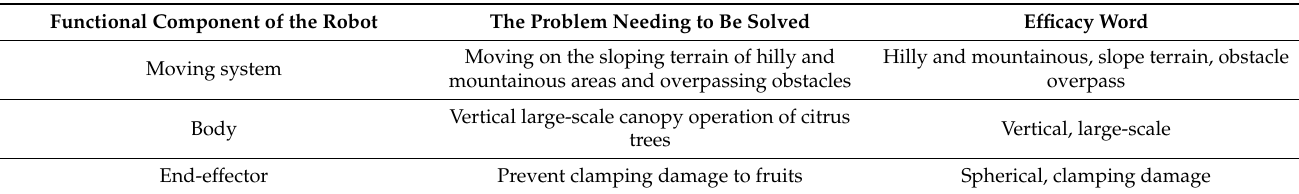
Table 4. Key problems to be solved for each functional component of the citrus picking robot and the corresponding efficacy